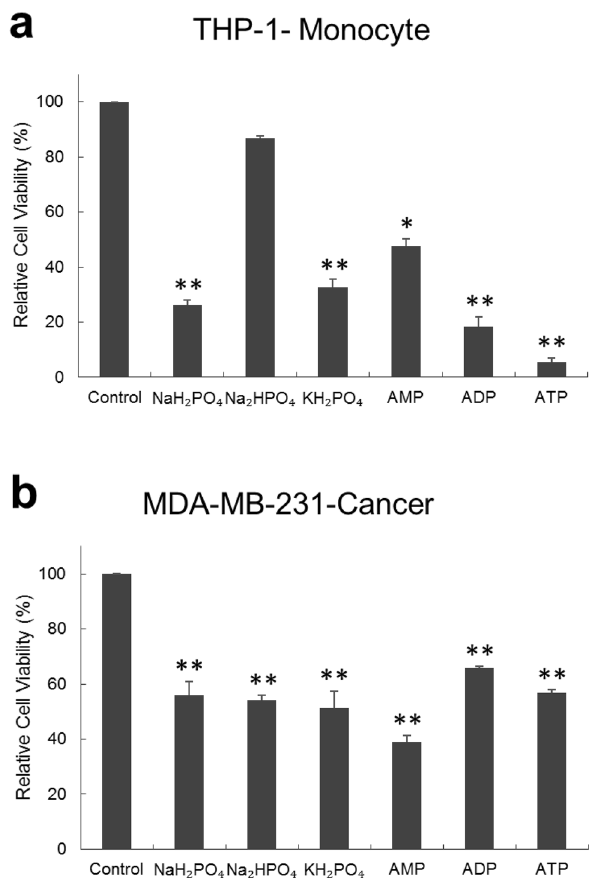
Figure 1. Toxicity of different phosphate compounds to ( a ) THP-1, human monocyte cell line, and ( b ) MDA-MB-231, human breast cancer cell line, evaluated after 48 h of incubation with the phosphate compound. All phosphate-containing compounds reduced viability of both cell types significantly except Na 2 HPO 4 , which only reduced the viability of MDA-MB-231 cells but not that of THP-1 cells. Experiment was done in triplicate and the sample number for each replicate is